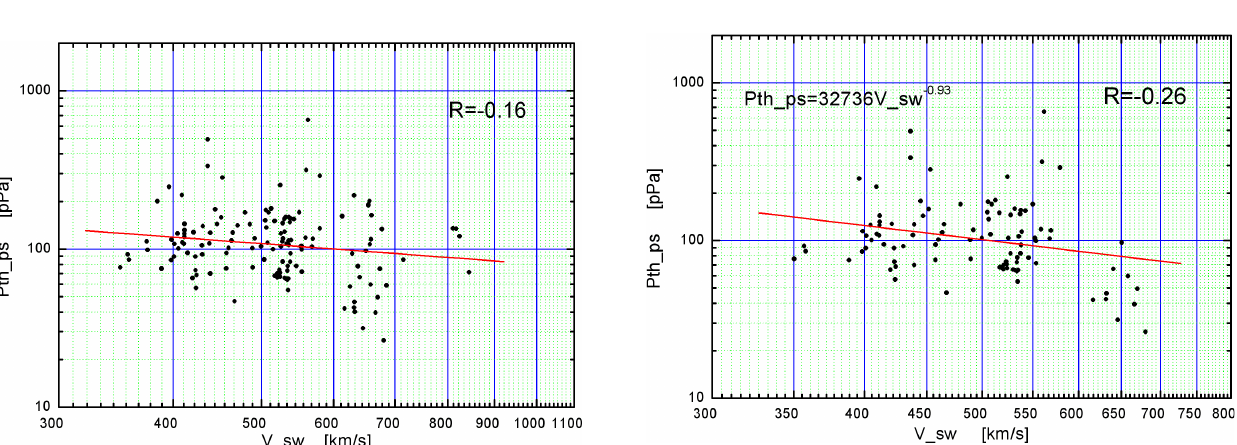
Fig. 6. The relationship between the speed of the solar wind and the ion temperature in the plasma sheet.